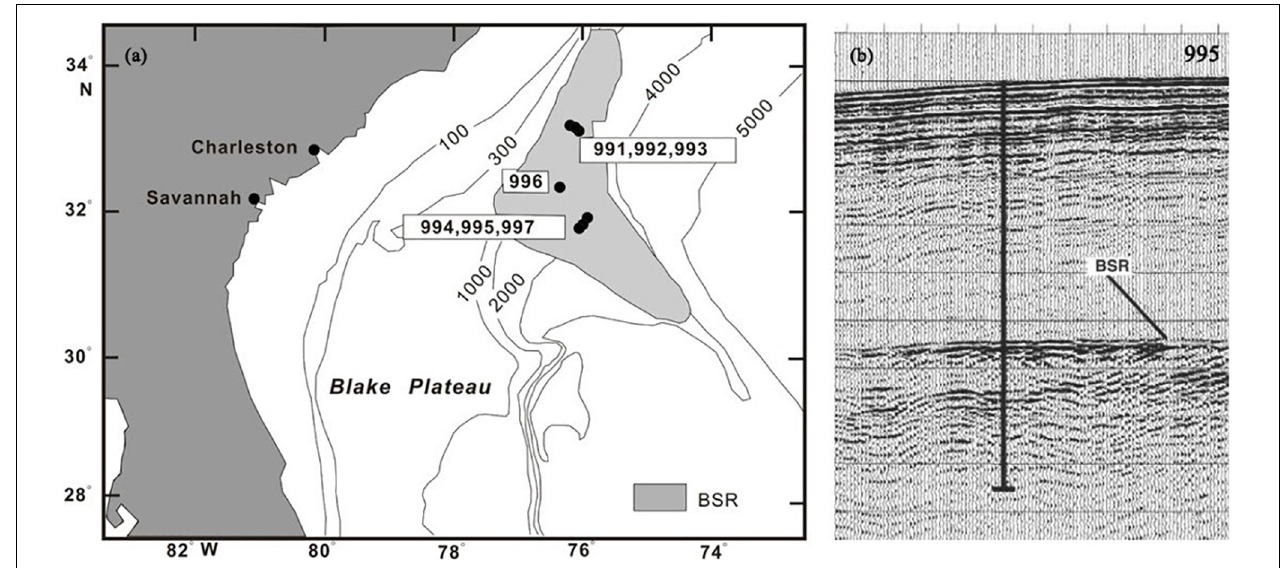
FIGURE 2 | (a) Map showing the location of the ODP Leg 164 and the BSR area in gray. (b) Seismic reflection profile across Site 995 showing the location of BSR (Paull et al., 1996).